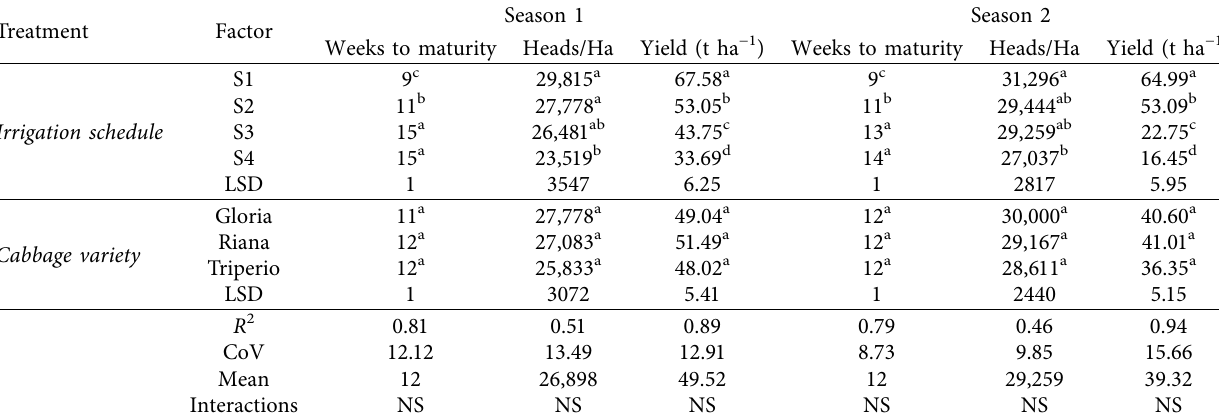
Figure 1: Cumulative quantity of irrigation water added in the four irrigation schedules (S1, S2, S3, and S4) during the study period. The small letters represent treatment variations, while the capital letters represent seasonal variations per treatment. Table 2: Growth and yield response of different cabbage varieties to different drip irrigation schedules.